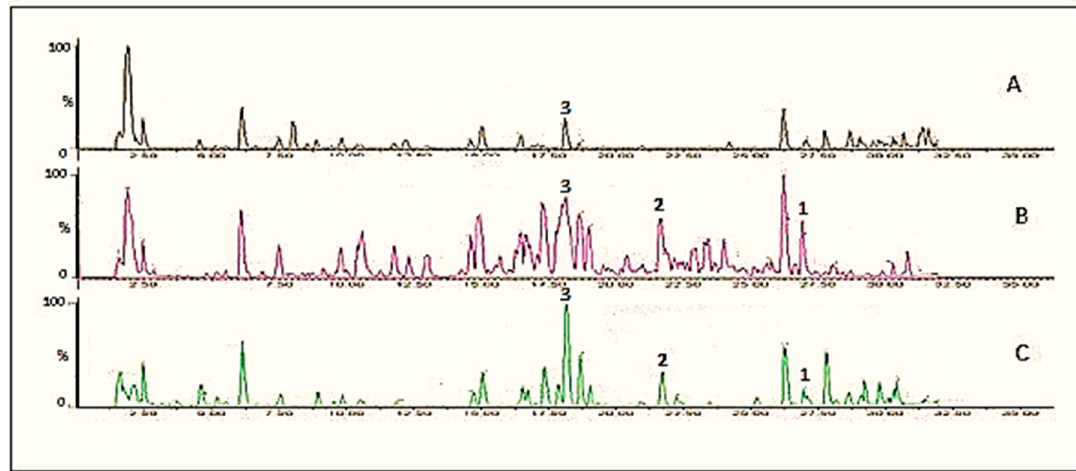
Figure 1. UPLC chromatograms of extract of cauliflower outer leaves, A , control; B , fermented with Rhizopus oryzae for 2 days; C , fermented with Rhizopus azygosporus for 4 days. The numbers indicate the following compounds: 1 = kaempferol; 2 = kaempferol-3-O-glucoside, 3 =